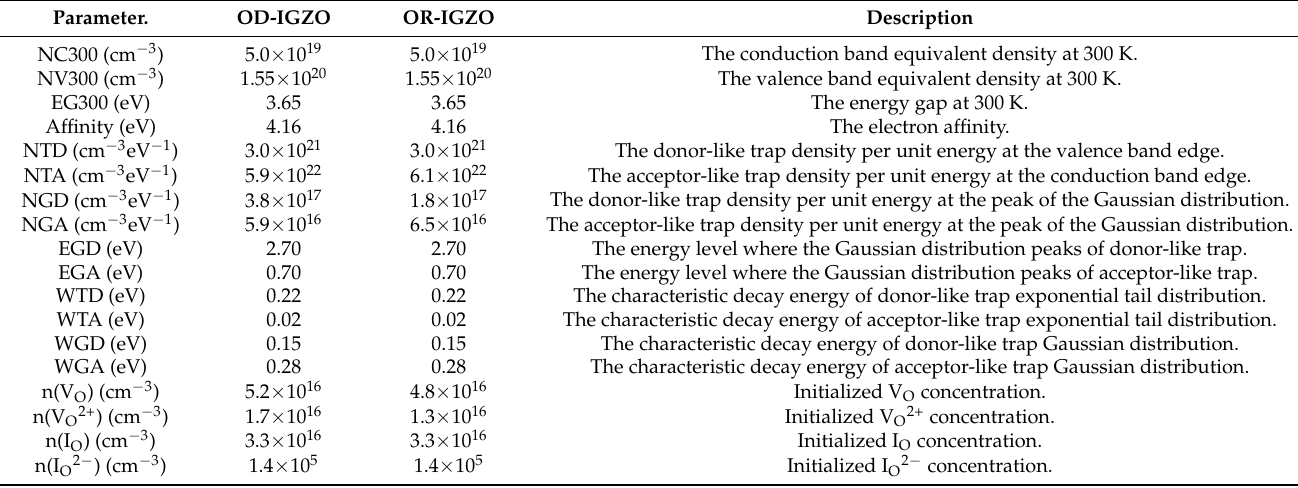
Table 3. Typical simulation parameters for a-IGZO films in